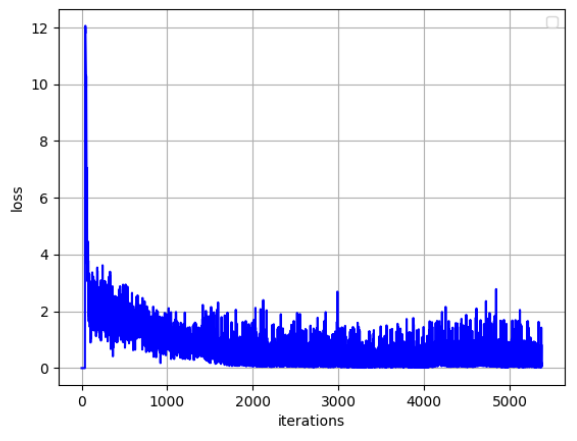
Figure 9. Trend graph of loss value.